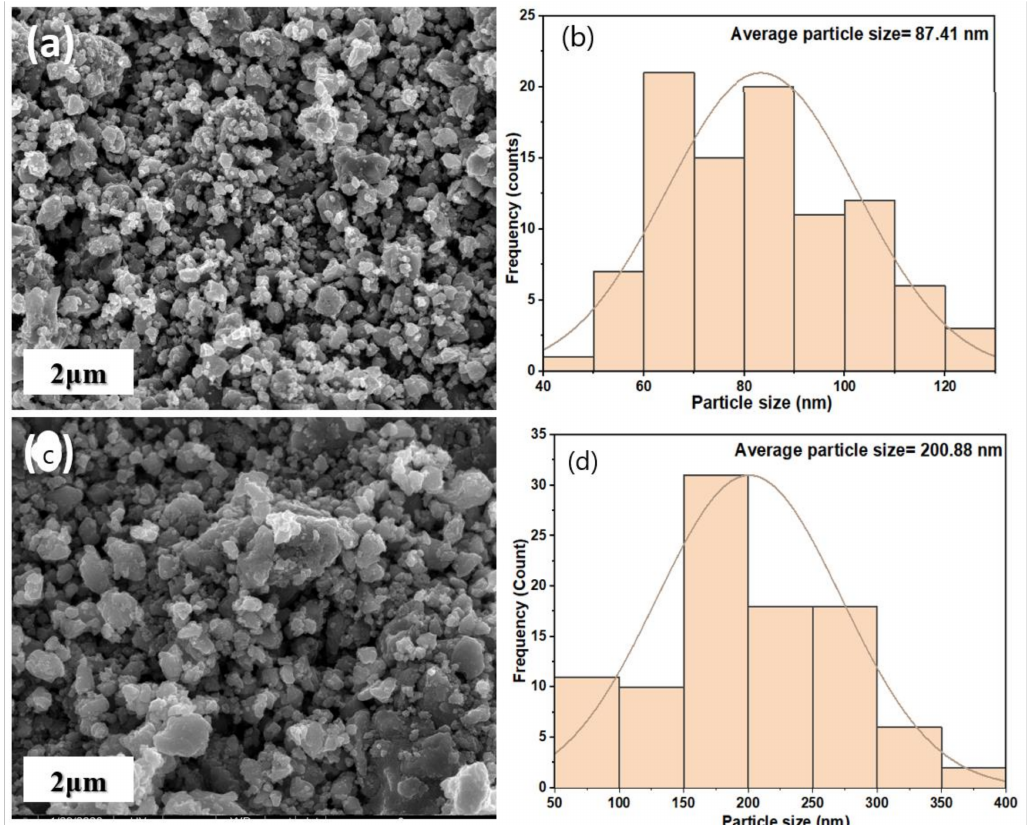
Figure 3. SEM (scanning electron microscopy) images for magnetite ( a ) before and ( c ) after adsorption; average particle size ( b ) before adsorption and ( d ) after adsorption.